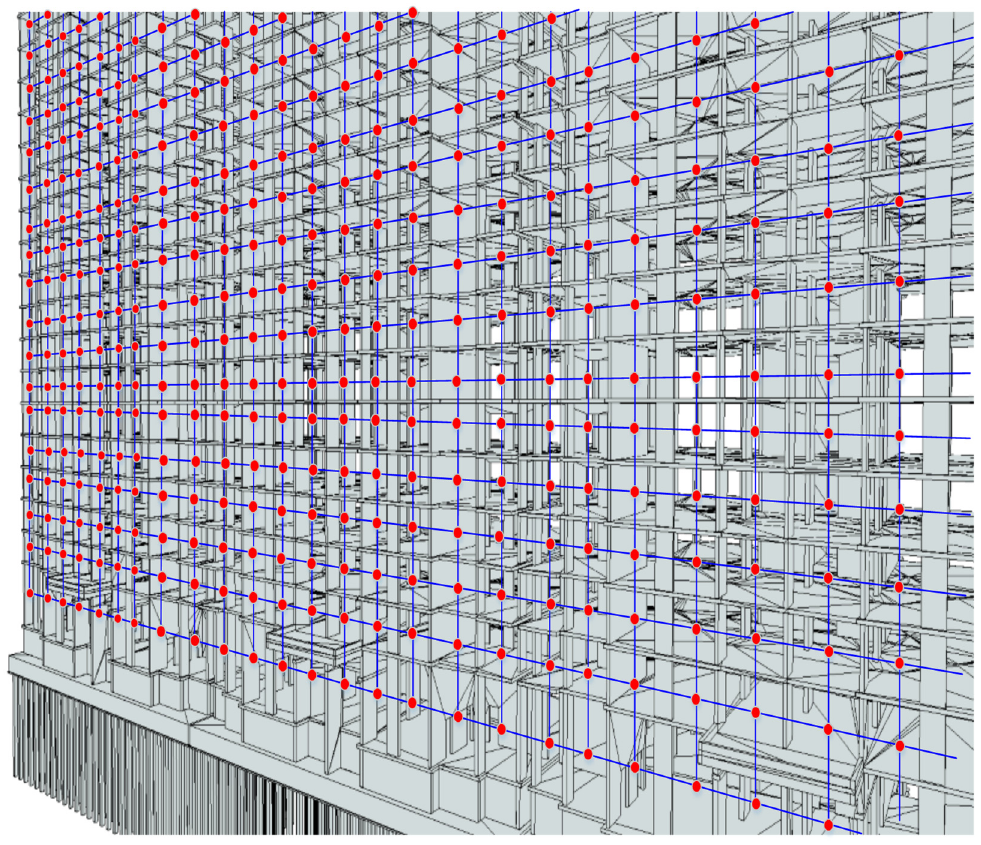
Figure 2. Illustration of a possible layout of network nodes in a multi-story building according to the proposed model.